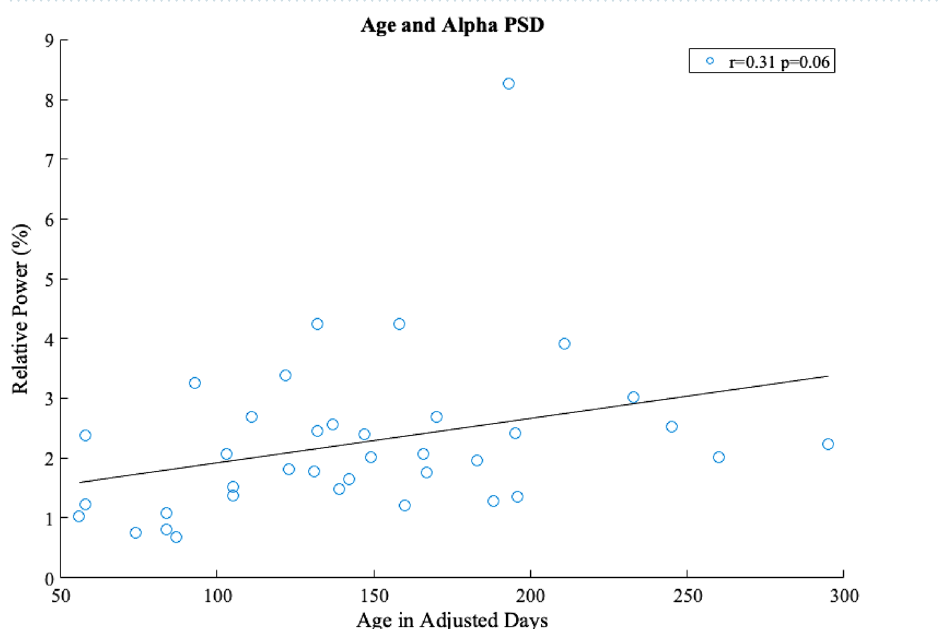
Figure 3. Correlation of alpha band power (6–9 Hz) from motor cortices (C3, Cz, and C4) with adjusted age in days. Each circle represents the alpha band power from an individual session. The bold line shows the least- squares fitted line along age. The r and p values are the results from the correlation